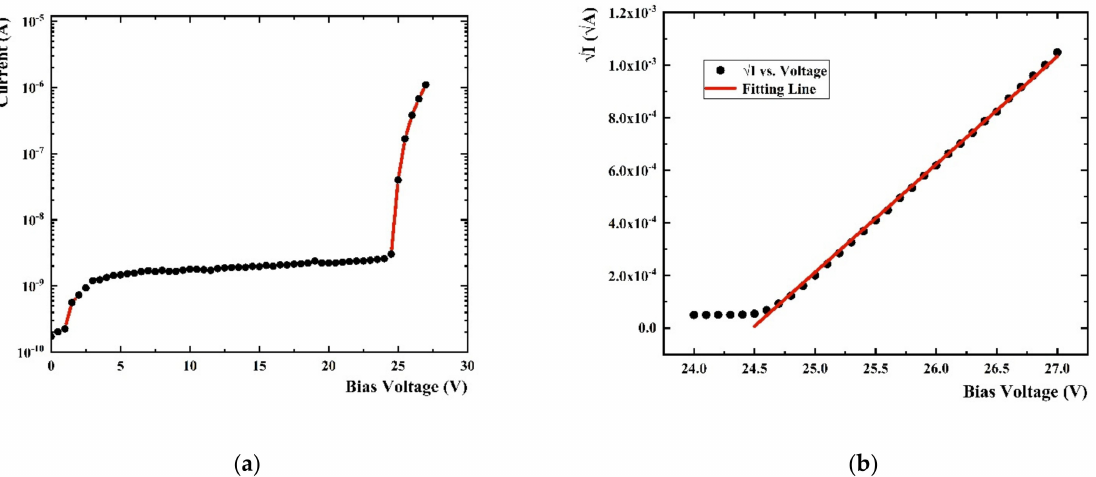
√ √ I / A vs. bias voltage plot at